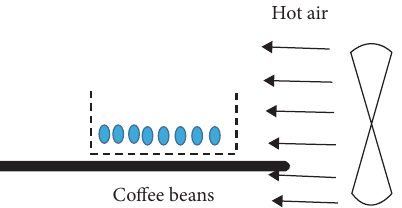
Figure 1: Experimental setup of packed bed roaster used in the present